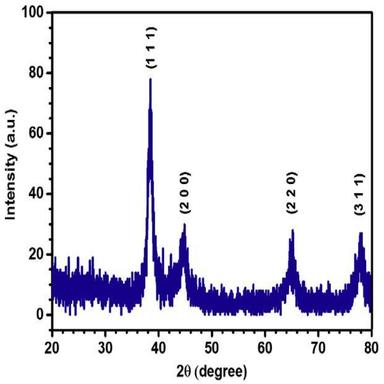
XRD spectrum of AuNPs synthesized using Lonicera japonica flower extract.